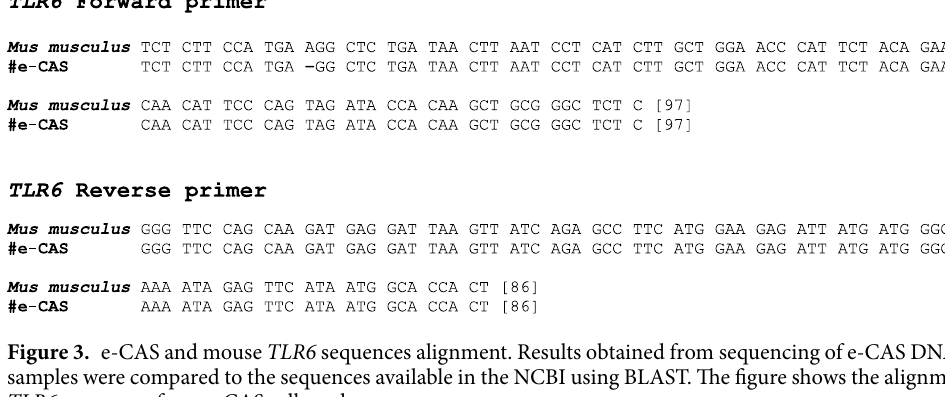
Figure 3. e-CAS and mouse TLR6 sequences alignment. Results obtained from sequencing of e-CAS DNA samples were compared to the sequences available in the NCBI using BLAST. The figure shows the alignment of TLR6 sequences from e-CAS cells and mouse.